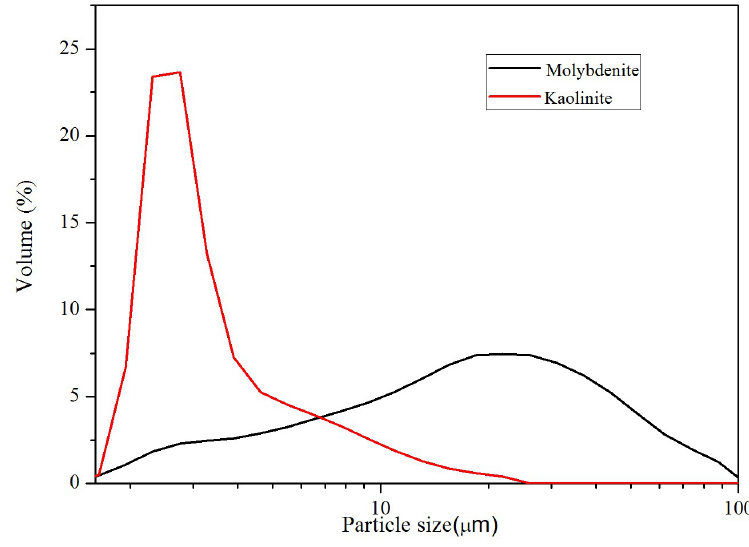
Figure 2. Particle size distribution of molybdenite and kaolinite samples.